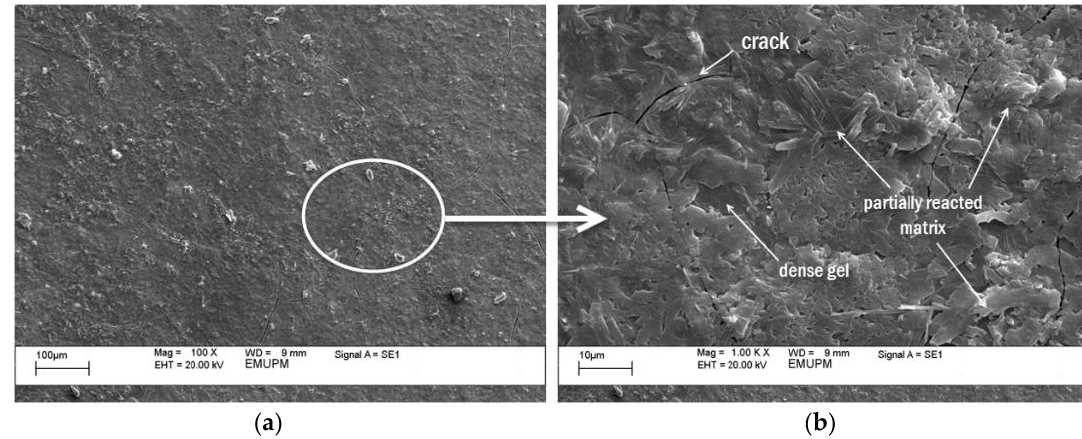
Figure 12. SEM micrograph of geopolymer binder with the lowest adhesion strength (sample S26). ( b ) is the magnification of ( a ).